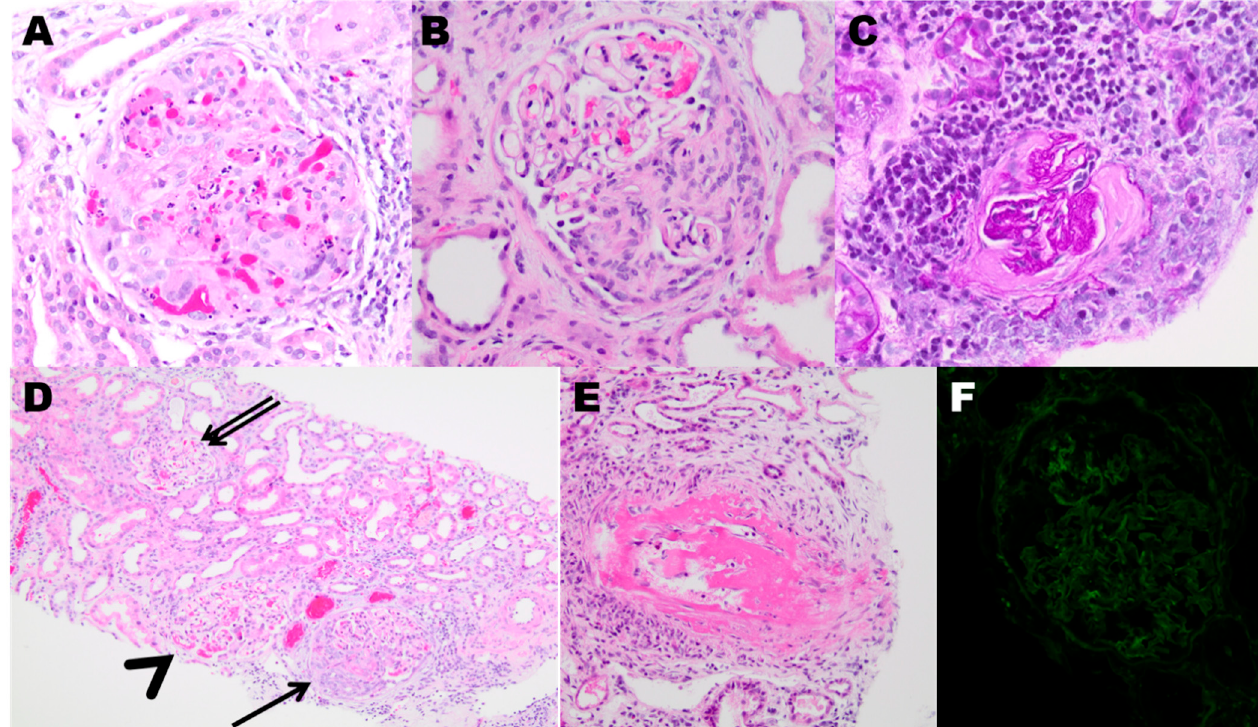
Figure 2. The kidney biopsy in AAV. ( A ) A glomerulus with an active global cellular crescent with segmental necrosis, Hematoxylin and Eosin (H&E), Magnification 200×. ( B ) A glomerulus with segmental fibrocellular crescent, H&E, Magnification 200×. ( C ) A glomerulus with fibrous crescent, Periodic-Acid Schiff (PAS), Magnification 200×. ( D ) Glomeruli in different stages of involvement, including active cellular crescent (single arrow), segmental necrotizing lesion (arrowhead) and uninvolved glomerulus (double arrows), H&E, Magnification 100×. ( E ) Necrotizing vasculitis with severe fibrinoid changes of the arterial wall, H&E, Magnification 200×. ( F ) Immunofluorescence is negative for immunoglobulins.